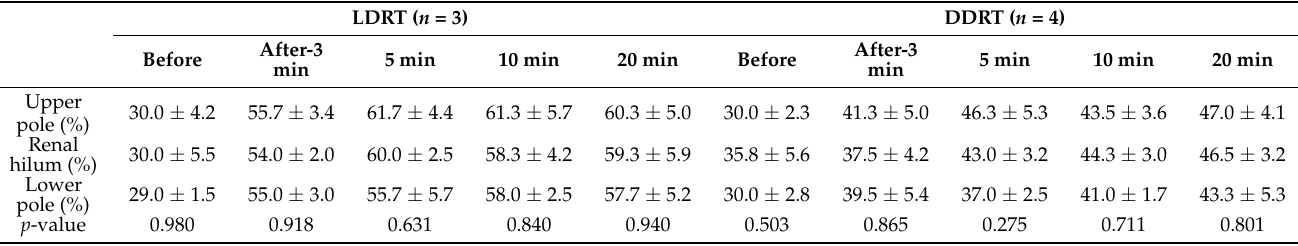
Table 2. Comparison of tissue oxygen saturation (rSO 2 ) levels measured at three regions (upper pole, renal hilum, and lower pole) of the kidney allograft in either living or deceased donor renal transplants before and after reperfusion at 3, 5, 10 and 20